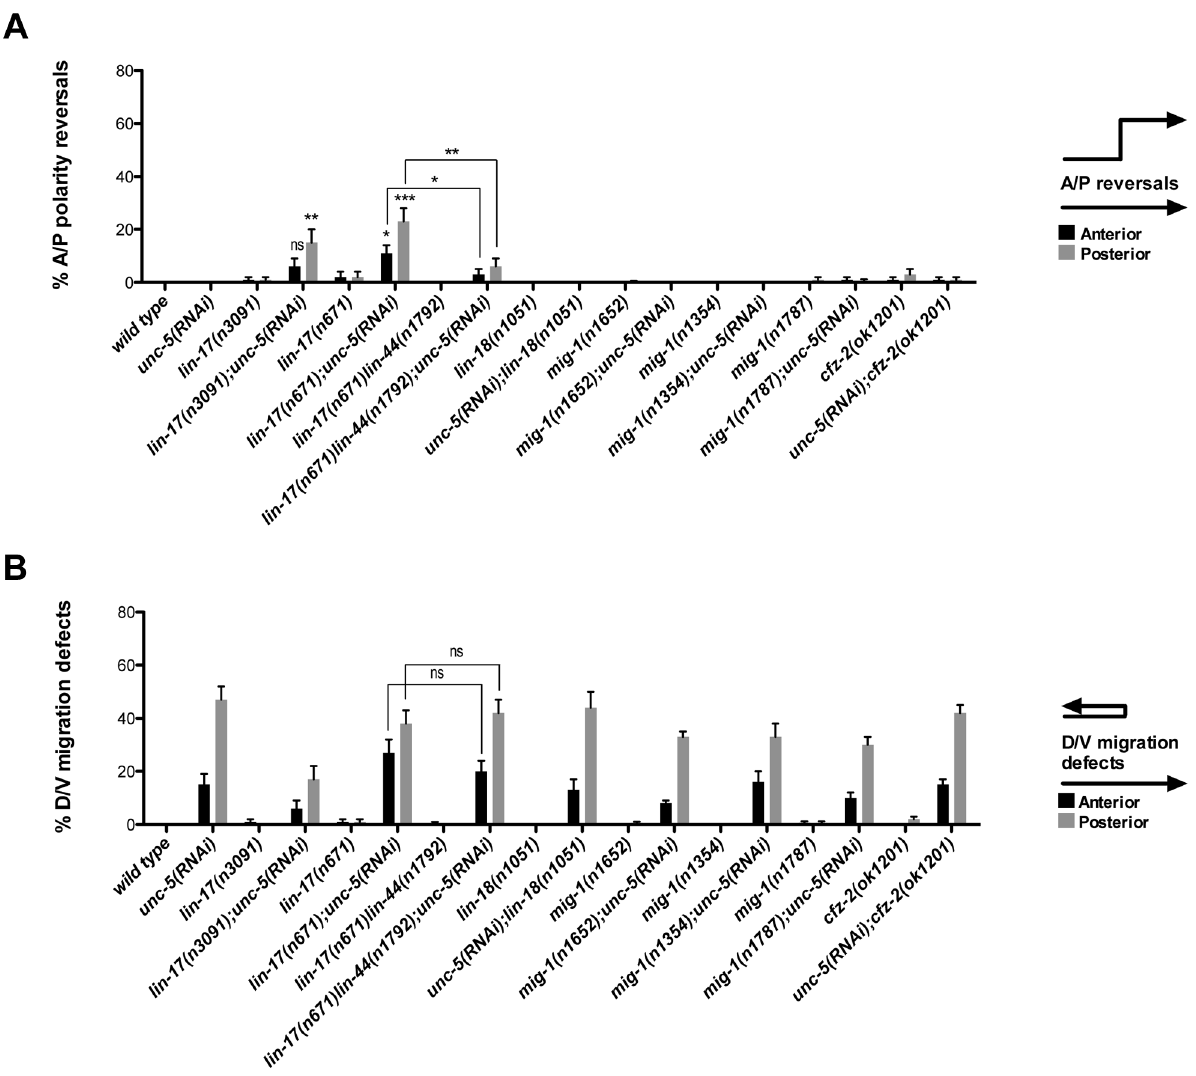
Figure 3. UNC-5 and the Wnt Frizzled receptor LIN-17 function redundantly to determine DTC phase 3 A/P polarity. (A) The effects of unc-5(RNAi) on the frequency of phase 3 A/P polarity reversals in single and double mutants of Wnt receptor-encoding genes are shown for anterior (black bars) and posterior (grey bars) DTCs. The corresponding raw data are presented in Table S3. Error bars indicate the standard error of the sample proportion. Comparisons of A/P polarity reversals were made between paired single and double deficits or as indicated by the connecting lines. ***P , 0.00001 **P , 0.001; *P , 0.05; ns=not significant. (B) Quantification of percent phase 2 D/V migration failures in the populations analyzed and presented in (A). The phase 2 D/V migration failures result from impairing unc-5 function, and reflect the efficacy of the unc-5(RNAi)